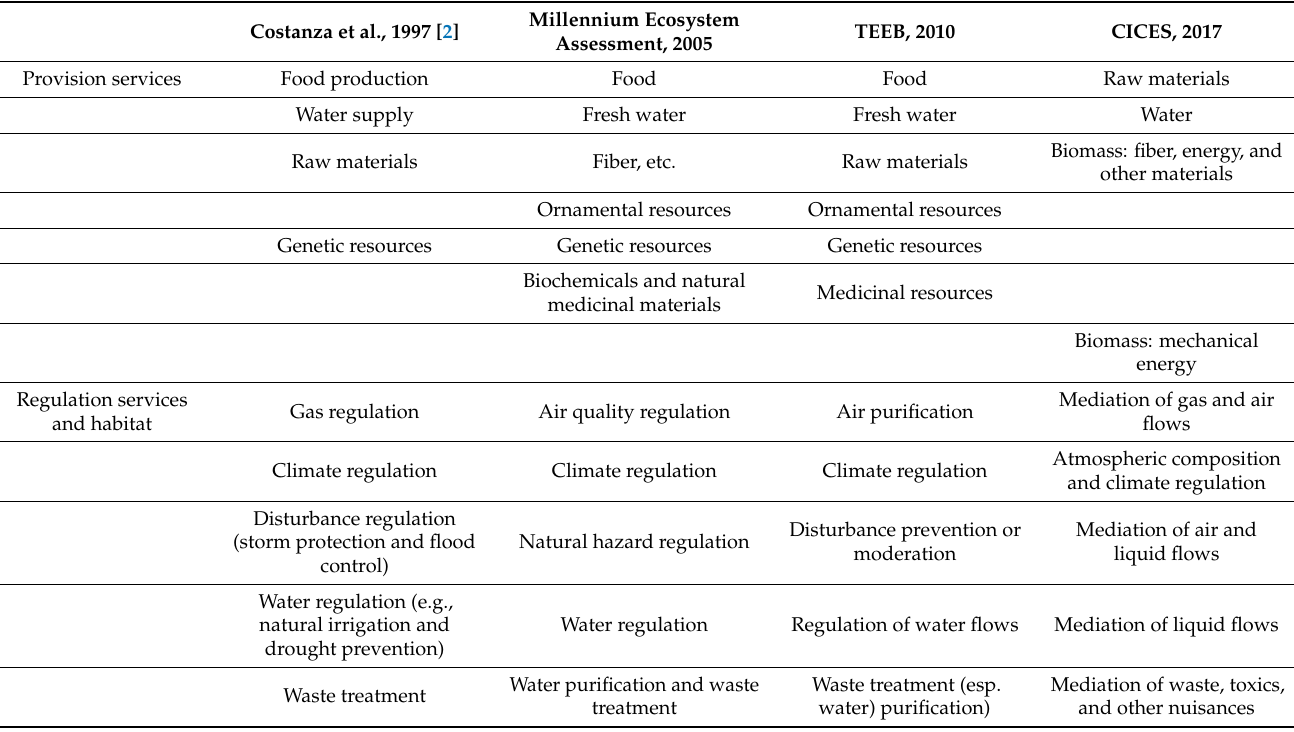
Table 2. Comparison of four main ecosystem service classification systems used worldwide and their differences and similarities